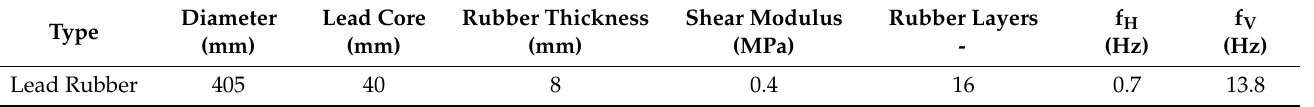
Table 3. Properties of LRB and resulting isolation system properties.